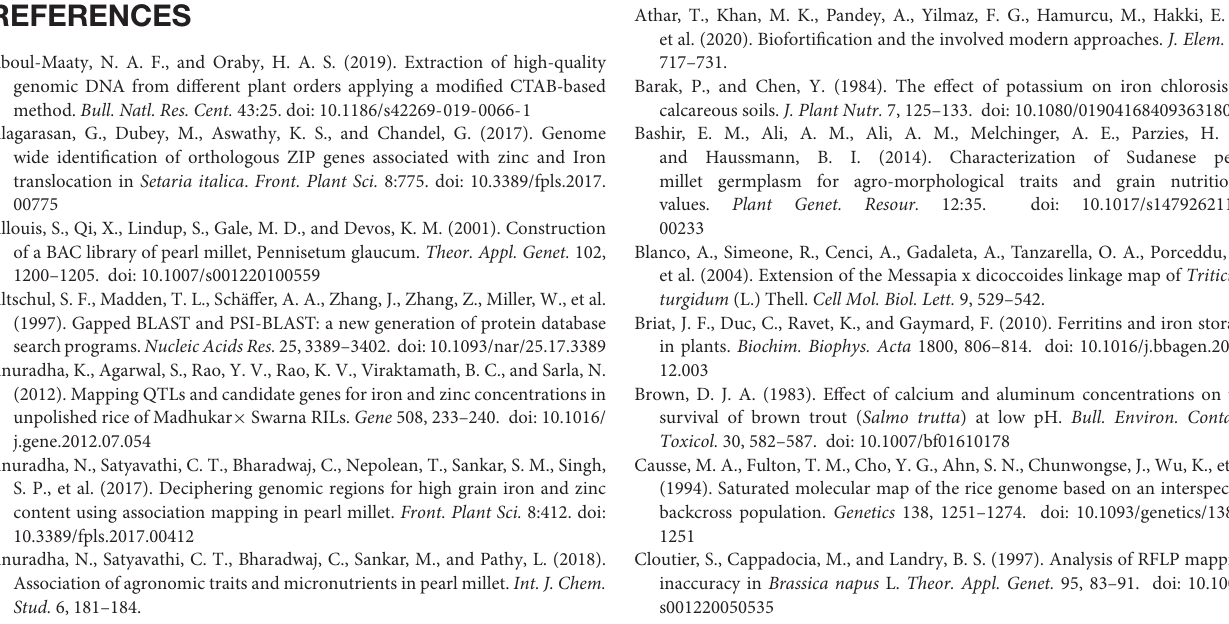
Supplementary Figure 1 | A to D shown the QTLs for grain Fe content on LG 2,3,5, and 7 at Delhi location. Supplementary Figure 2 | A and B shown the QTLs for grain Zn content at LG 2 and 3 at Delhi location. Supplementary Figure 3 | A to D shown the QTLs for grain Fe content on LG 2,3,5, and 7 at Dharwad location. Supplementary Figure 4 | A and B shown the QTLs for grain Zn content at LG 2 and 3 at Dharwad location. Supplementary Figure 5 | A to D shown the QTLs for grain Fe content on LG 2,3,5, and 7 at Jodhpur location. Supplementary Figure 6 | A and B shown the QTLs for grain Zn content at LG 2 and 3 at Jodhpur